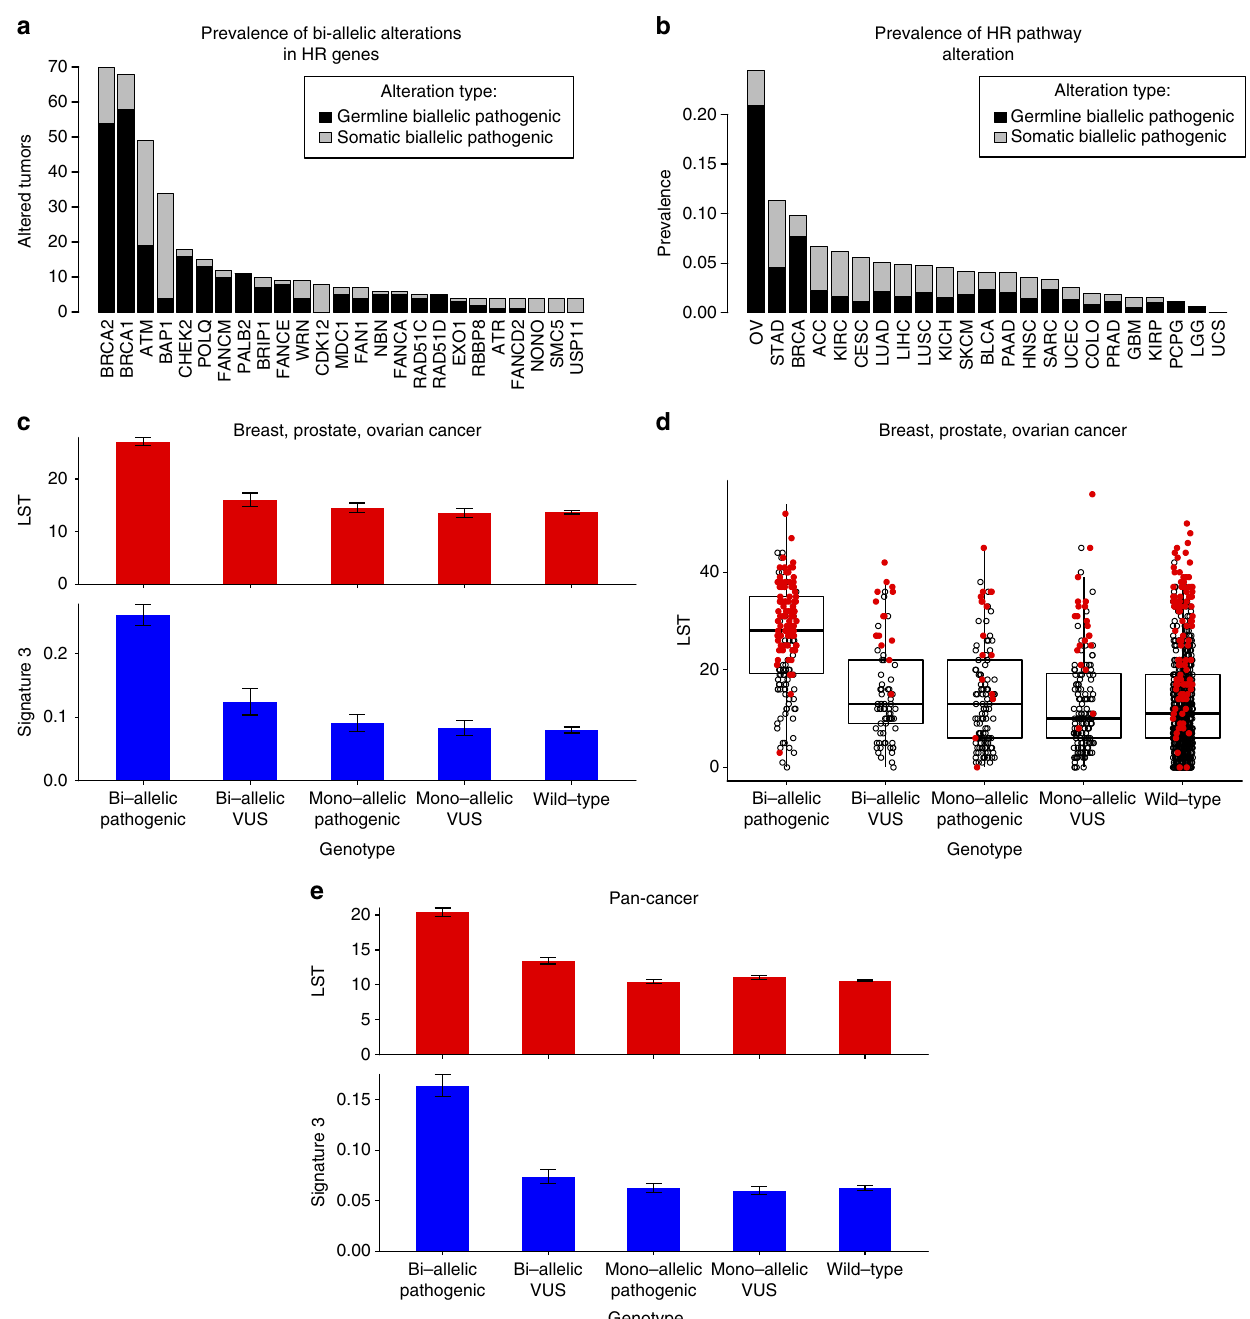
Fig. 1 Bi-allelic pathogenic alterations affecting HR-related genes affect multiple cancer types and are associated with genomics features of HR de fi ciency. a Incidence of bi-allelic pathogenic alterations in HR-related genes in TCGA samples strati fi ed according germ-line or somatic origin. It is important to note that germ-line bi-allelic alterations most commonly consisted of a germ-line pathogenic mutation and a somatic loss of heterozygosity. b Incidence of bi- allelic alterations of HR-related genes according to cancer type. c Association of LST and signature 3 in HBOC cancers. Bi-allelic pathogenic alterations and bi-allelic VUSs in HR-related genes are associated with elevated LST and signature 3 (pathogenic: p < 2.2*10 − 16 and p < 2.2*10 − 16 , respectively; VUS: p = 0.02 and p = 0.017, respectively). Mono-allelic pathogenic alterations were not associated with either LST or signature 3 ( p = 0.26 and p = 0.14, respectively). d LST for each genotype; cases with dominant signature 3 colored red (see methods). The box plot center line represents the median, the box limits represent the 1st and 3rd quartiles, respectively, and the whiskers extend from box limits to the largest value up to 1.5 times the interquartile range. e Pan-cancer analysis shows bi-allelic pathogenic alterations associated with an elevated LST and signature 3 ( p < 2.2*10 − 16 and p < 2.2*10 − 16 , respectively). Mono-allelic pathogenic alterations were not associated with elevated LST or signature 3 ( p = 0.98 and p = 0.76, respectively). All p -values from the Wilcoxon-rank sum test. Error bars represent